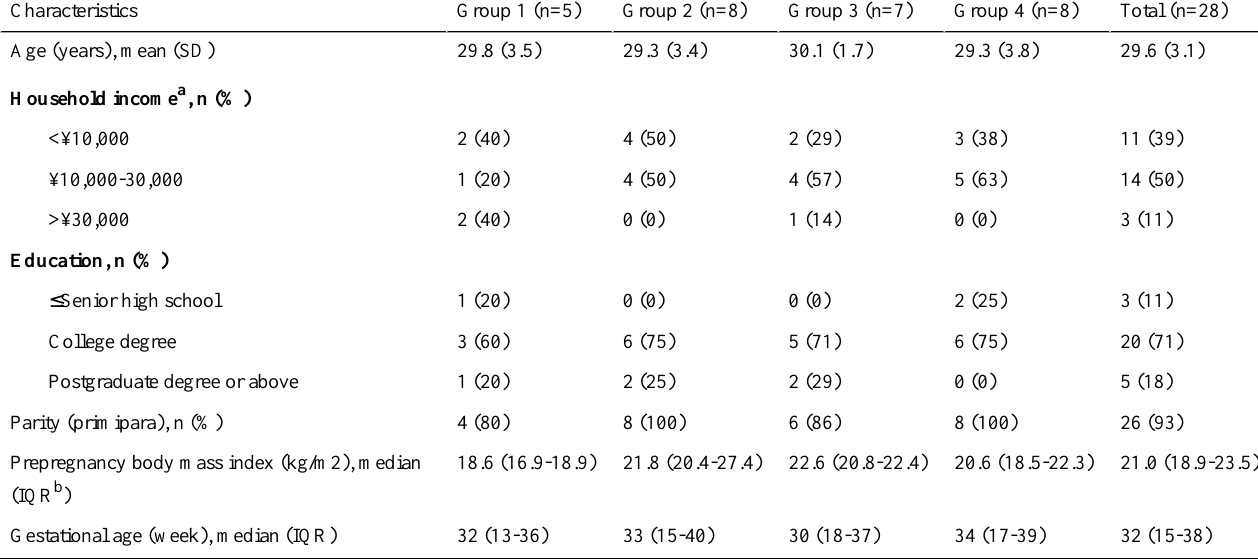
Table 5. Demographic characteristics of focus group participants in Shanghai,